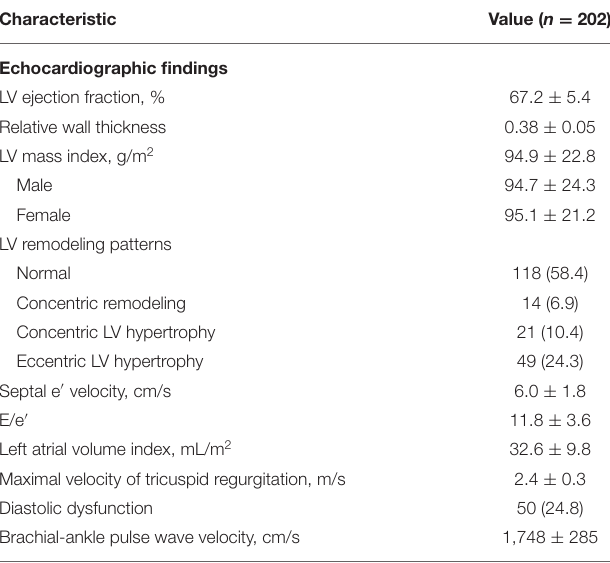
TABLE 2 | Parameters of transthoracic echocardiography and baPWV of study patients. Characteristic